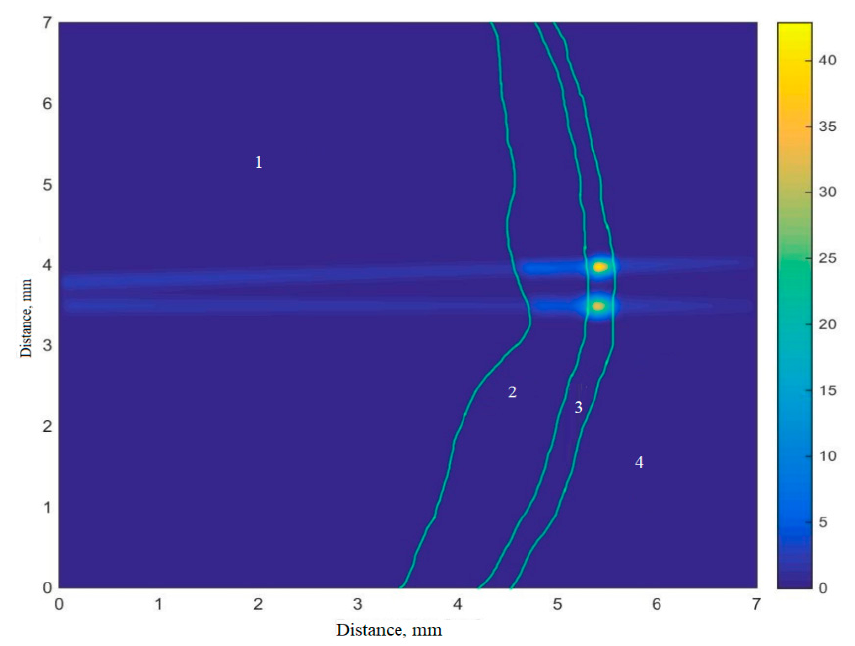
Figure 8. Modeling of laser action for the formation of two coagulates: 1—vitreous layer, 2—retinal layer, 3—epithelial layer, 4—vascular layer.